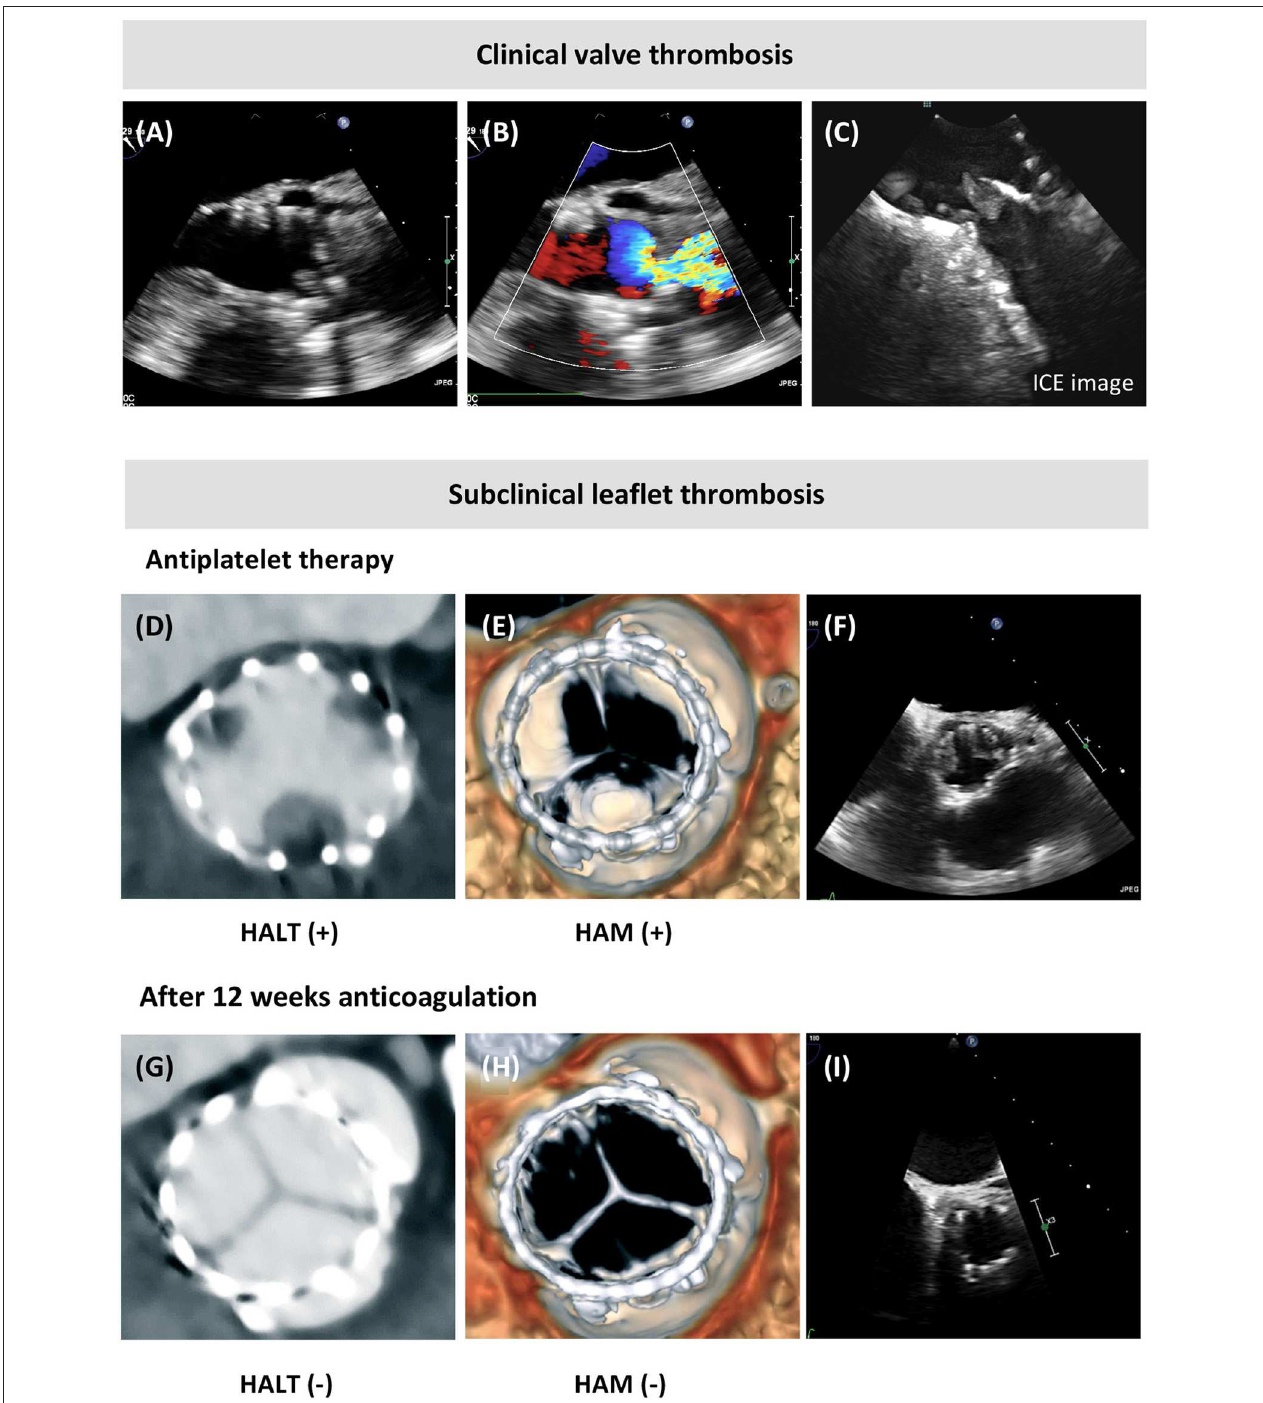
FIGURE 2 | Clinical valve thrombosis and subclinical leaflet thrombosis. (A,B) Transesophageal echocardiography (TEE) showing valve thrombosis and turbulent color flow over the transcatheter aortic bioprosthesis in a patient presenting with an elevated mean transvalvular gradient at transthoracic echocardiography (TTE, 37 mmHg) and dyspnea NYHA class 3–4, and this few years after TAVR. (C) The thrombotic mass at the aortic side of the prosthetic leaflets was confirmed by intracardiac echocardiography (ICE). (D,E) Incidental finding of hypoattenuating leaflet thickening (HALT) at the base of the transcatheter heart valve leaflets, with hypoattenuation affecting motion (HAM) visible in systole in the volume-rendered 4D computed tomography (4DCT) images; (F) this reduced leaflet motion of two leaflets was confirmed by TEE. (G–I) Resolution of the leaflet thickening and reduced leaflet motion following 3 months of anticoagulation treatment, as shown by 4DCT and TEE